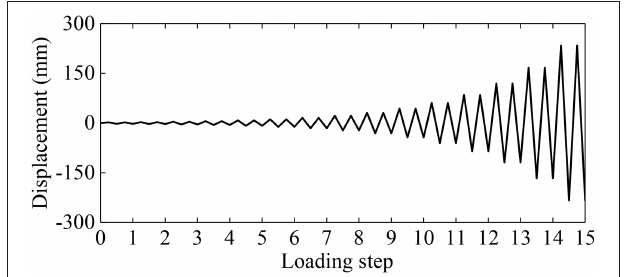
FIGURE 9 | Loading protocol for cyclic tests suggested by FEMA 461 (2007).